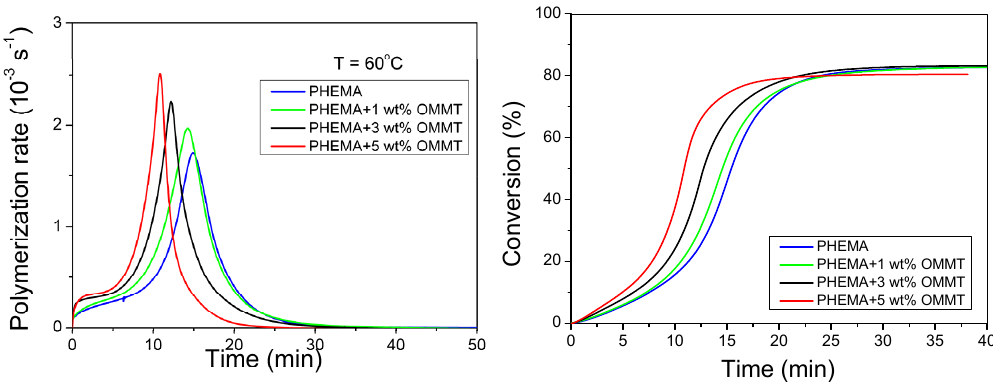
Figure 6. Effect of the amount of nano-OMMT on the variation of polymerization rate ( a ) and conversion ( b ) with time during polymerization of HEMA at 60 °C.